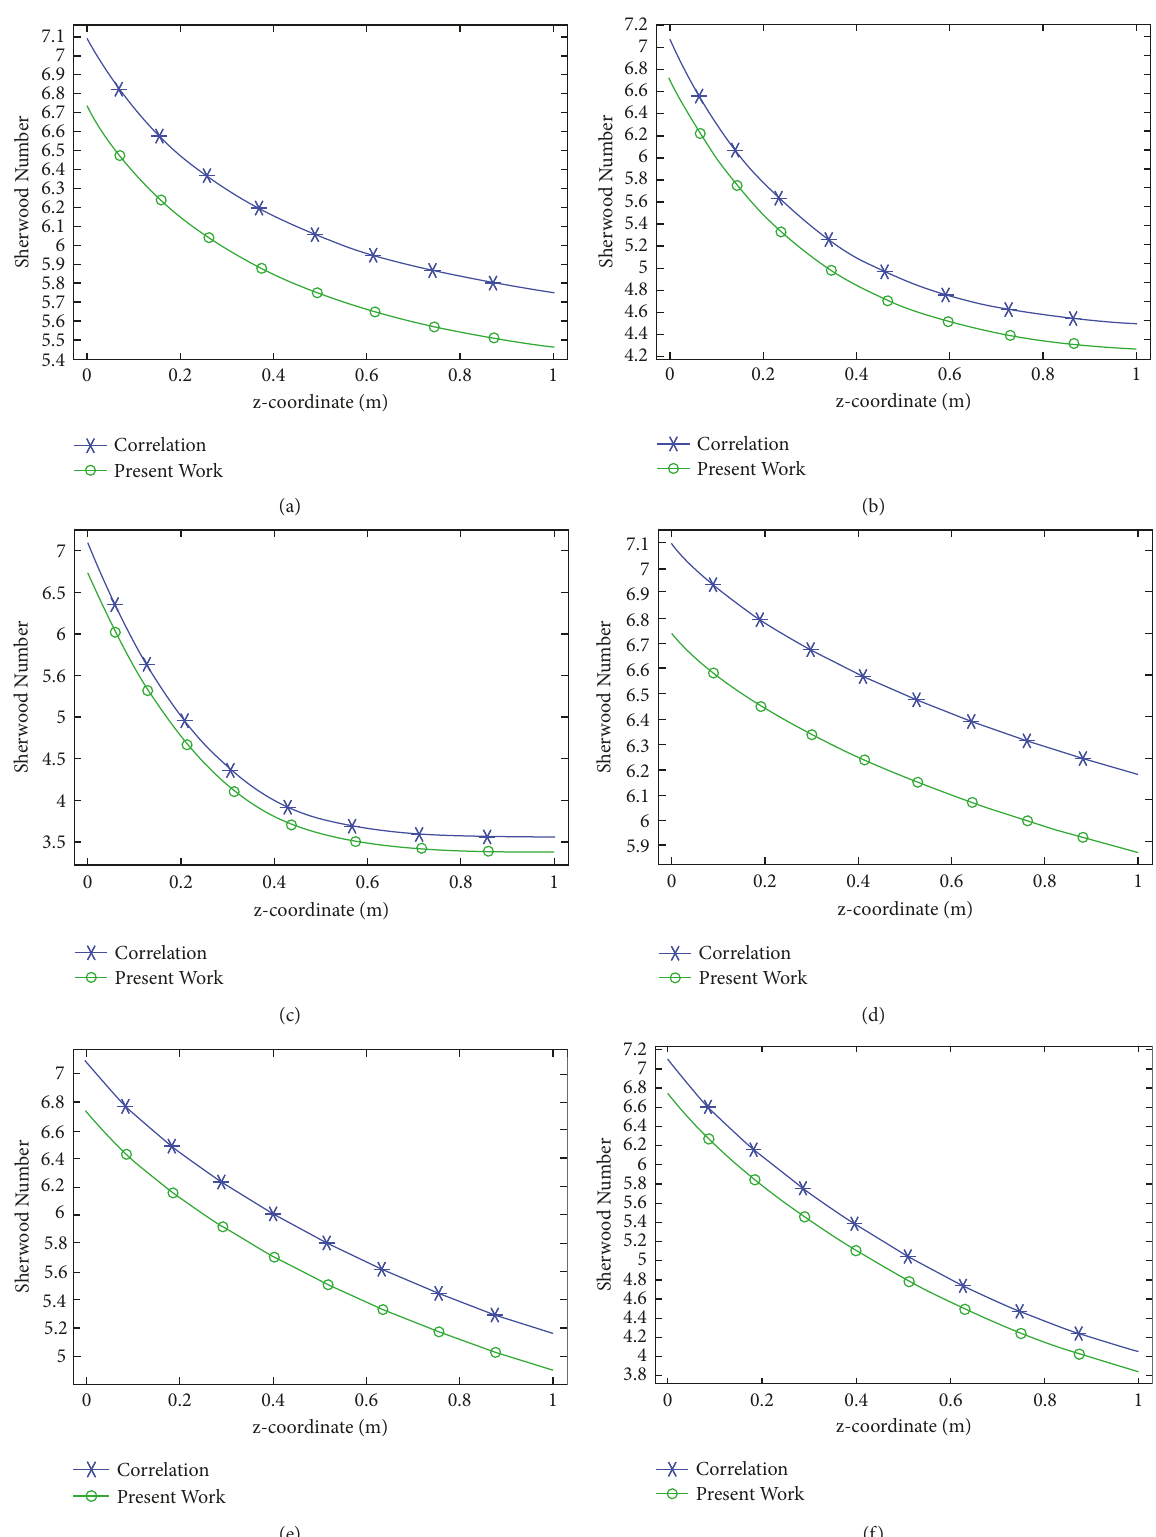
Figure 5: Comparison between the computed Sherwood number and the experimental correlation: (a) I.C � 1%, Re � 100, E � 75,000; (b) I.C � 2%, Re � 100, E � 75,000; (c) I.C � 3%, Re � 100, E � 75,000; (d)I.C � 1%, Re � 100, E � 77,000; (e) I.C � 2%, Re � 100, E � 77,000; (f) I.C � 3%, Re � 100, E �